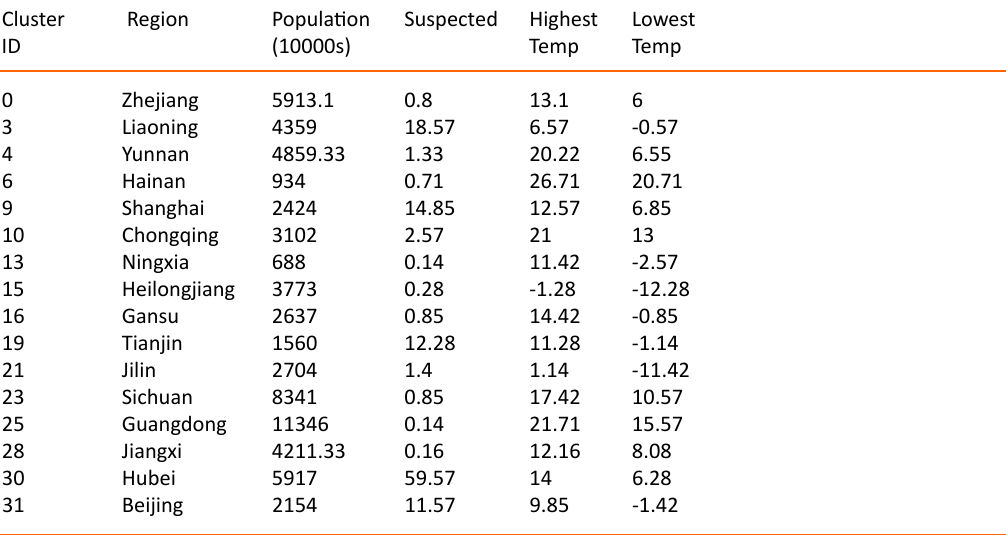
Table 7. K-means Cluster results on Suspected COVID-19 cases Vs